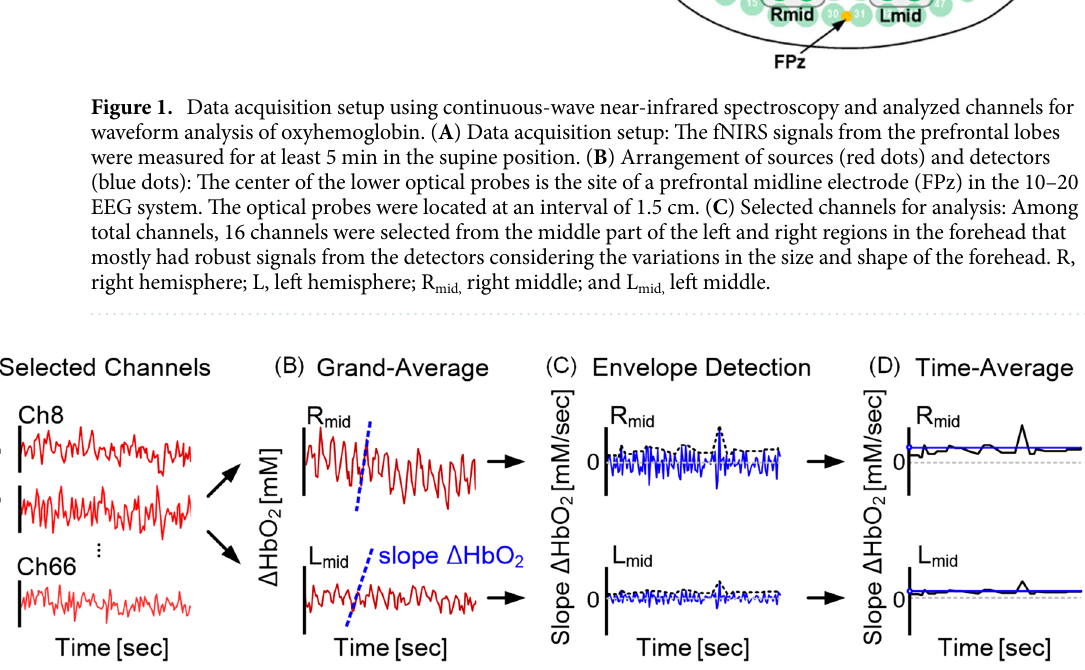
Figure 2. Typical example of data processing procedure. ( A ) Original ΔHbO2 signal of selected 16 channels of two included subjects from each group. ( B ) Grand averaged waveform of the HbO2 signals from the selected 16 channels into the left and right hemispheres to increase the integrity of the pulsatile oscillation using the synchronized response of averaged ΔHbO 2 ( C ) Envelope detection of maximum slope values of ΔHbO 2 in each hemisphere by time-differentiating between the two adjacent values of ΔHbO 2 reflecting the steepness of the pulsation at each sampling points ( D ) Average slope value calculated from the envelope of the slope ΔHbO 2 As described in Fig. 2A,B, the HbO 2 signals were averaged for each R mid and L mid regions to increase the integ- rity of the pulsatile oscillation by averaging the synchronized oscillatory response of ΔHbO 2 . The slope value of ΔHbO 2 was acquired by time-differentiating between the two adjacent values of ΔHbO 2 reflecting the steepness of the pulsation at each sampling point in each hemisphere (Fig. 2C). The upper envelope was detected from the oscillation of the slope value of ΔHbO 2 by extracting the local maximum values over a sliding window which represents the sharpness of the ΔHbO 2 wave. Finally, the upper envelope was averaged into a single representative slope value for the left and right hemispheres, respectively (Fig. 2D). The unit of the slope value was expressed in 10 –4 ·Fs mM/sec (Fs = 8.138 Hz as the sampling frequency). Statistical analyses. Patients were categorized into two groups based on the vascular reserve status (decreased vascular reserve vs. intact vascular reserve). Continuous variables including age, initial NIHSS, slope parameters and PI value were compared using Student’s t - or Mann–Whitney U -tests, and the proportions of